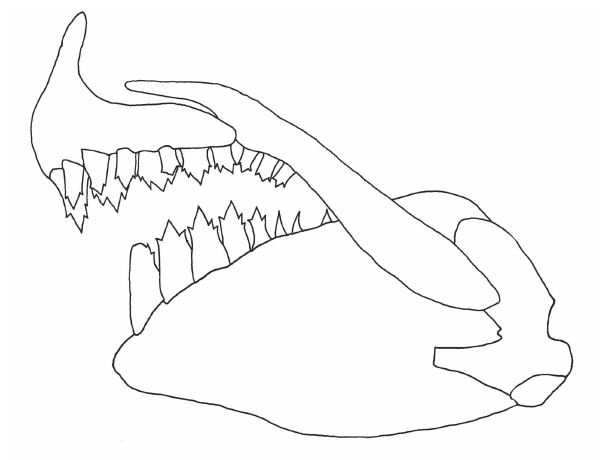
Fig. 5. Jaws of Hasemania crenuchoides , left side, DZSJRP 11039, 51.5 mm SL. Scale bar = 2